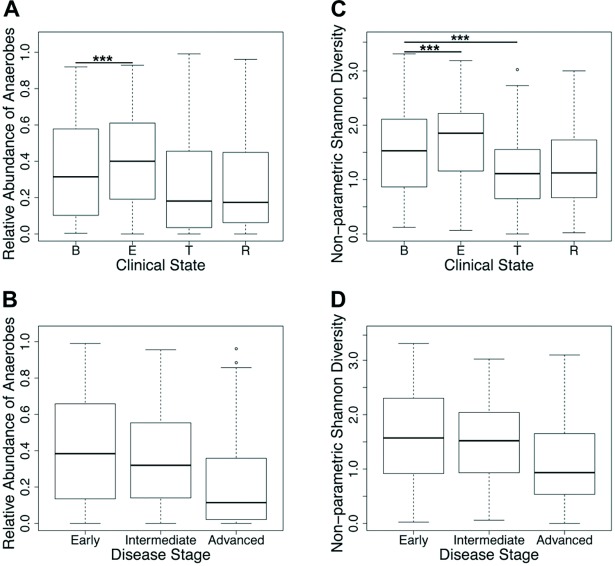
Relative abundance of anaerobic genera and Shannon diversity in bacterial communities based on patient clinical state and disease stage.The cumulative relative abundances of anaerobic genera (Actinomyces, Fusobacterium, Gemella, Granulicatella, Porphyromonas, Prevotella, Rothia, Streptococcus and Veillonella spp) are depicted by (A) clinical state and (B) disease stage. Bacterial community Shannon diversity is depicted by (C) clinical state and (D) disease stage. ***P ≤ 0.001 (GEE).